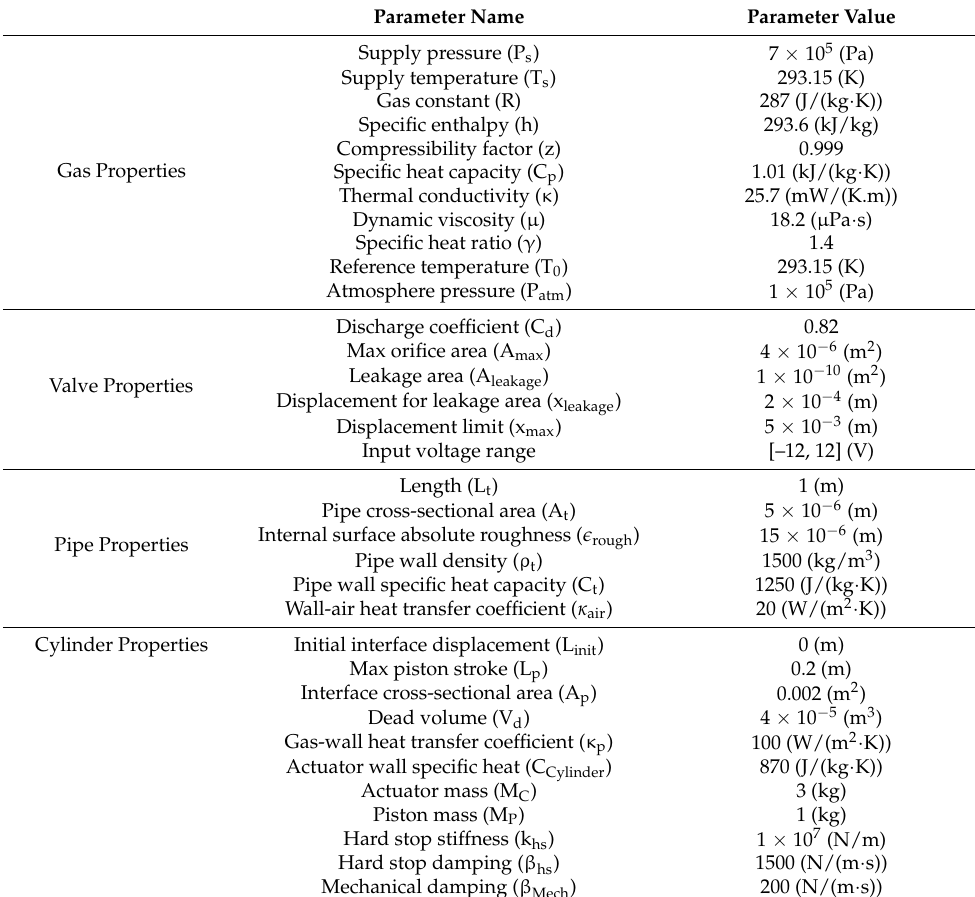
Table 1. Parameters values used in simulation.